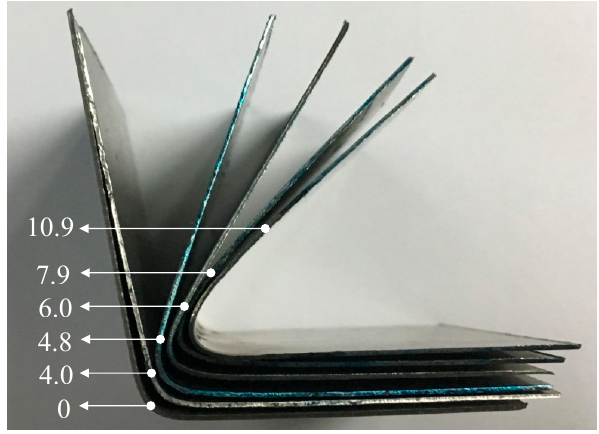
Figure 5. The formed parts after thrice forming at different current densities.